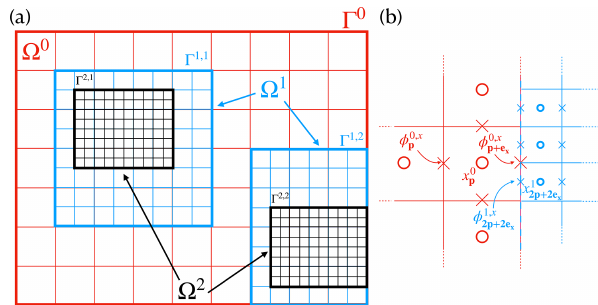
Figure A1. (a) Example of a block-structured mesh composed of three levels. Discrete-level domain (cid:127) 0 comprises the cell centers of the coarsest grid, (cid:48) 0 . Level domains (cid:127) 1 and (cid:127) 2 are each built from two separate rectangular blocks, each with their own separate grids. (b) Focus on the coarse–fine interface between (cid:127) 0 and (cid:127) 1 . Loca- tions of cell- and face-centered data are represented with circles and crosses, respectively. Face-centered data belonging to (cid:127) 0 ,x on the interface are replaced by averaging of (cid:127) 1 ,x (finer)